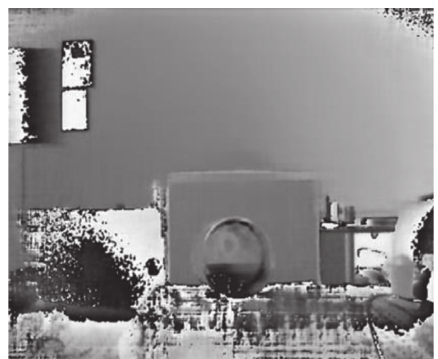
Figure 9: Convolutional neural network patching effect.